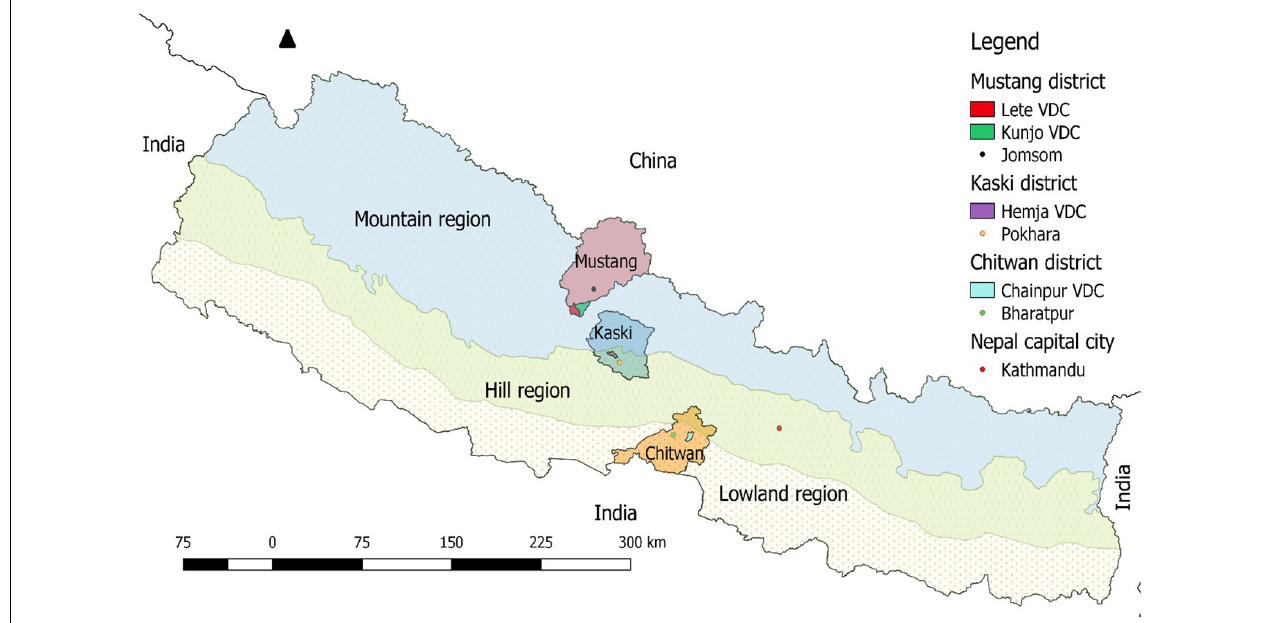
FIGURE 3 | Location of study sites in